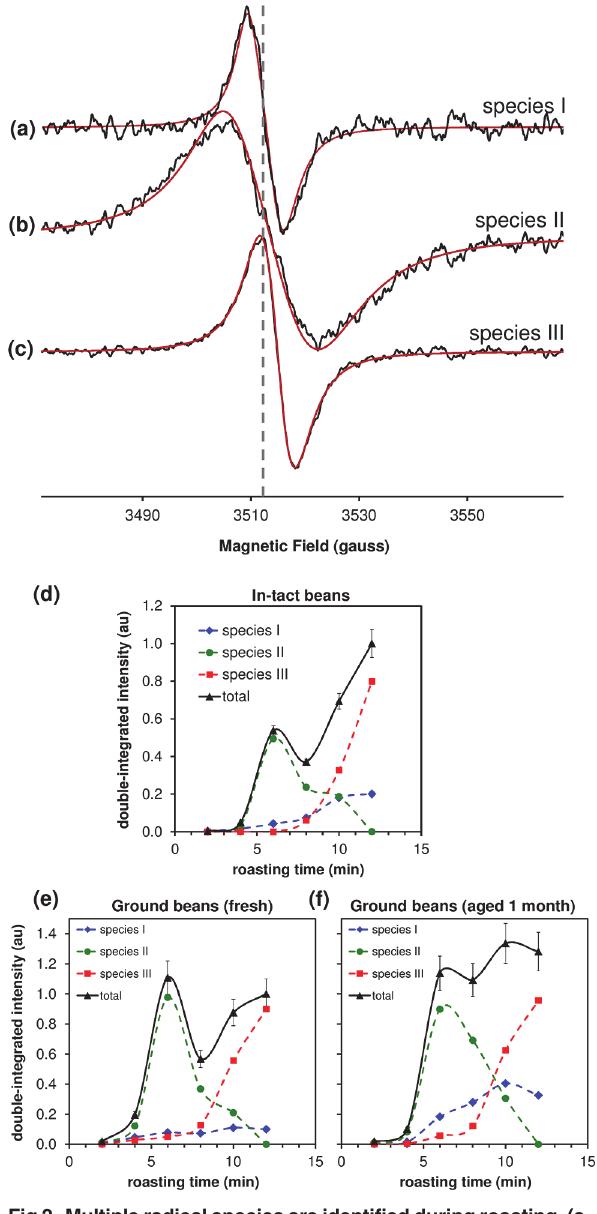
Fig 2. Multiple radical species are identified during roasting. (a – c) Experimental ( ― ) and simulated ( ― ) EPR spectra of three putative radicals present in whole and ground coffee beans, isolated as shown in S4 Fig Using the basis spectra in a – c , the total EPR signal intensity (determined by double integration) of the experimental spectra from (d) in-tact beans, (e) freshly ground and (f) same grounds aged 1 month, was decomposed into contributions from species I – III. Details of the decompositions are shown in S5 – S7 Figs The dashed vertical line in a – d is positioned at the line center of species I to aid comparison of the different spectra. Error bars in d represent the mean and standard error of the intensity of the EPR spectra from individual beans. Error bars in e - f depict an arbitrary ± 10% error associated with EPR spectra from a single sample of ground beans. Note that the intensity in e-f is comparable, but the intensity in d is not directly comparable with e-f